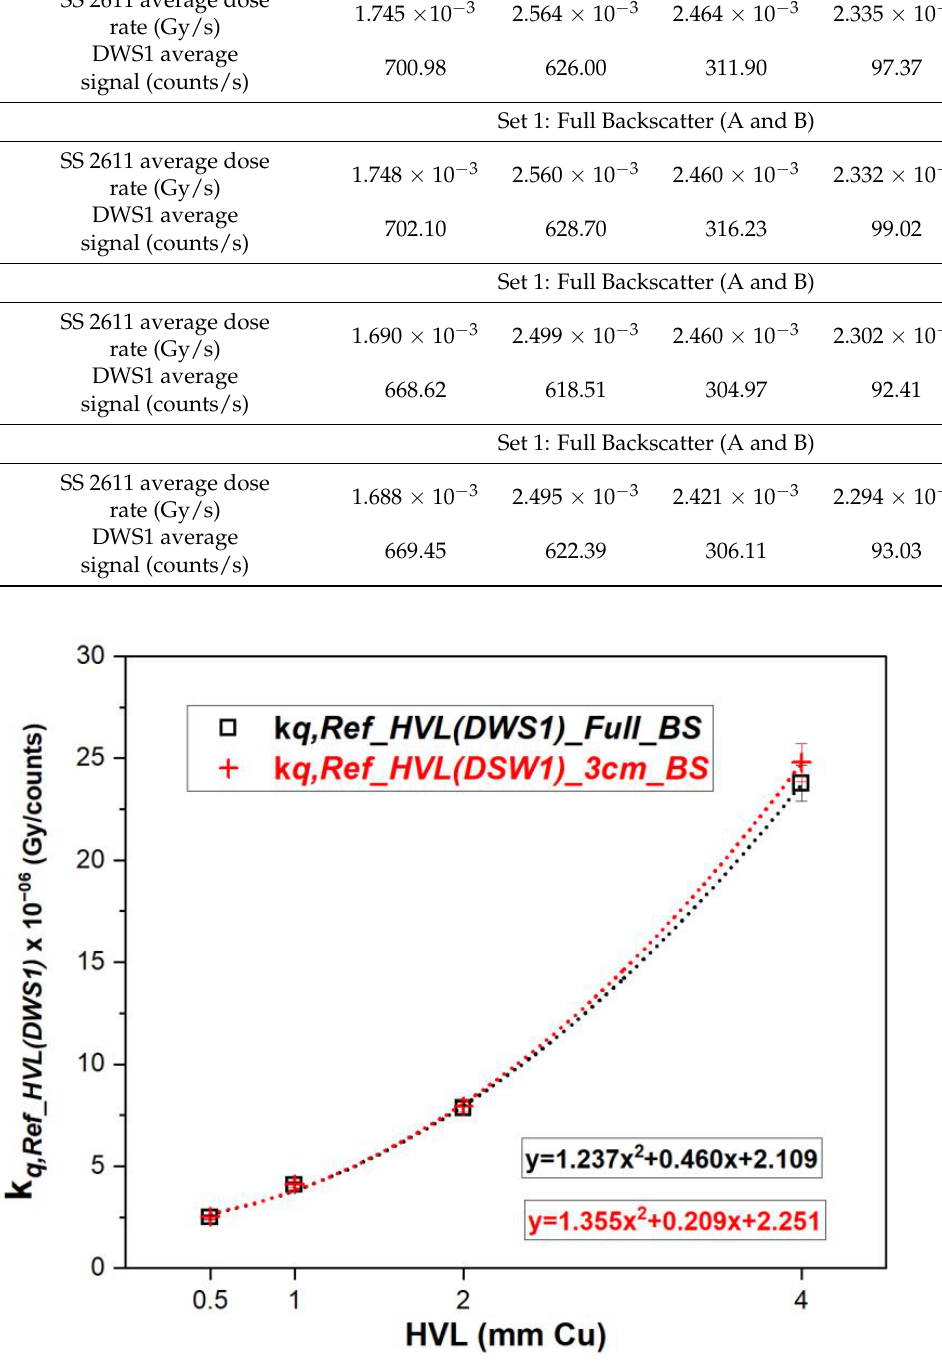
Figure 5. Beam quality dependent calibration coefficient, kq, determined in conditions of full and 3 cm backscatter, respectively. Error bars stand for the combined standard uncertainty (k = 1). When not visible, the value is smaller than the data point marker. The largest difference between the calibration coefficients for full and 3 cm backscatter conditions was 4.31% for the hardest beam quality (i.e., 4 mm Cu HVL). The